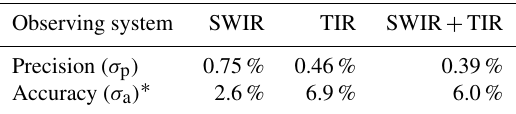
Table 2. Uncertainty in τ OH serving systems.